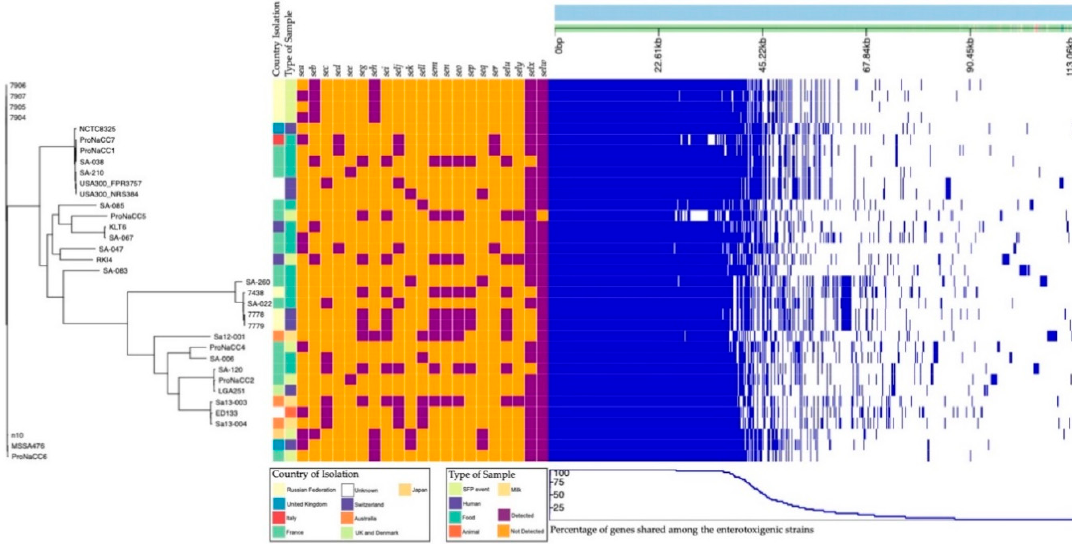
Figure 10. Pan-genomic analysis of the 35 enterotoxigenic strains. On the left side is the phylogenetic tree of the strains included in this study. On the central heatmap is the the geographical location of isolation and sources (colour legend in the picture). The detection of the gene coding for enterotoxins is reported as presence and absence with the colours purple and orange respectively.